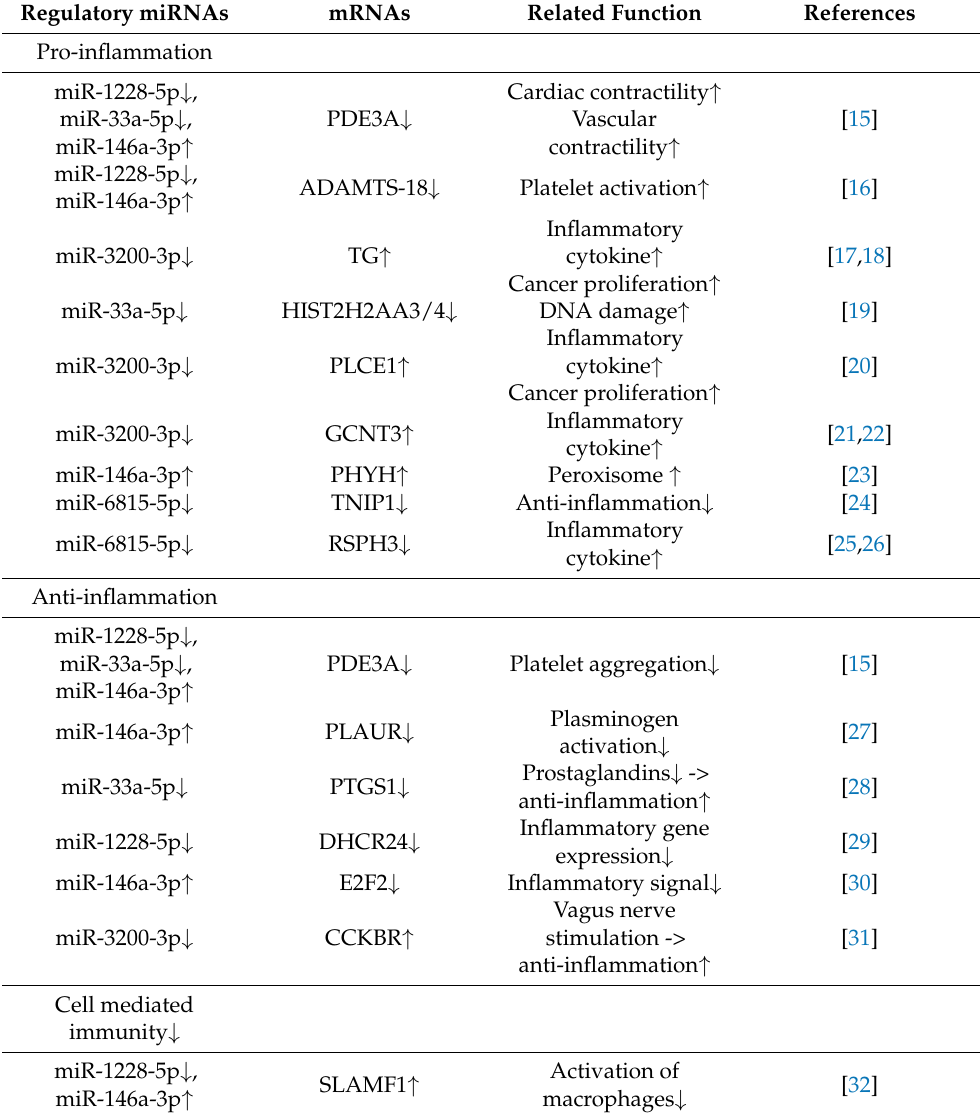
Table 2. Biological functions of RNAs that changed significantly according to the upregulation or downregulation of the five main miRNAs are reviewed focusing on the inflammatory response. mRNAs Related